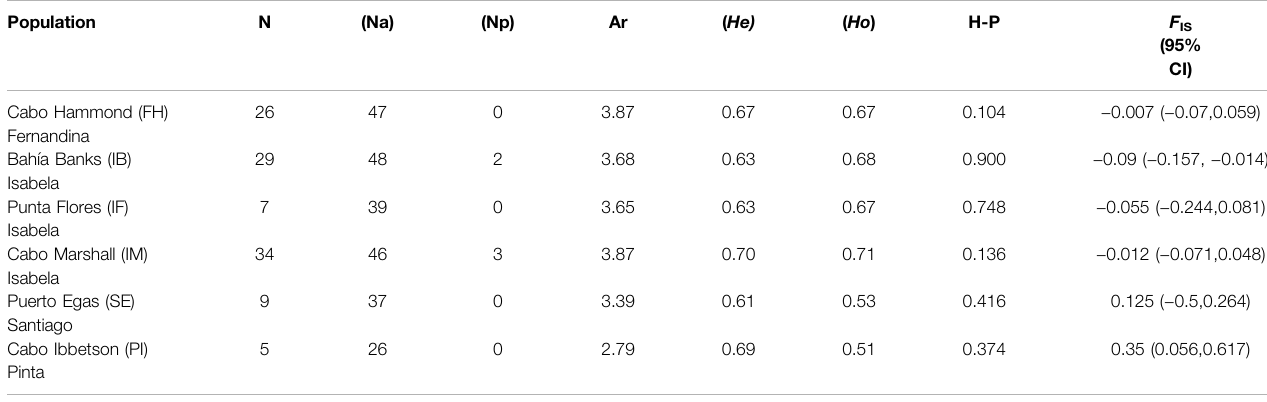
TABLE 2| Genetic diversity indexes obtained foreach rookery based on microsatellite data. N= number ofindividuals analyzed; Na = number ofalleles; Np = private alleles; Ar=allelicrichness; He =expectedheterozygosity; Ho =observedheterozygosity;H-P=Hardy – Weinbergtestofneutrality;and F IS Inbreedingcoef fi cient.Valuesinbold are signi fi cant ( p < 0.001).